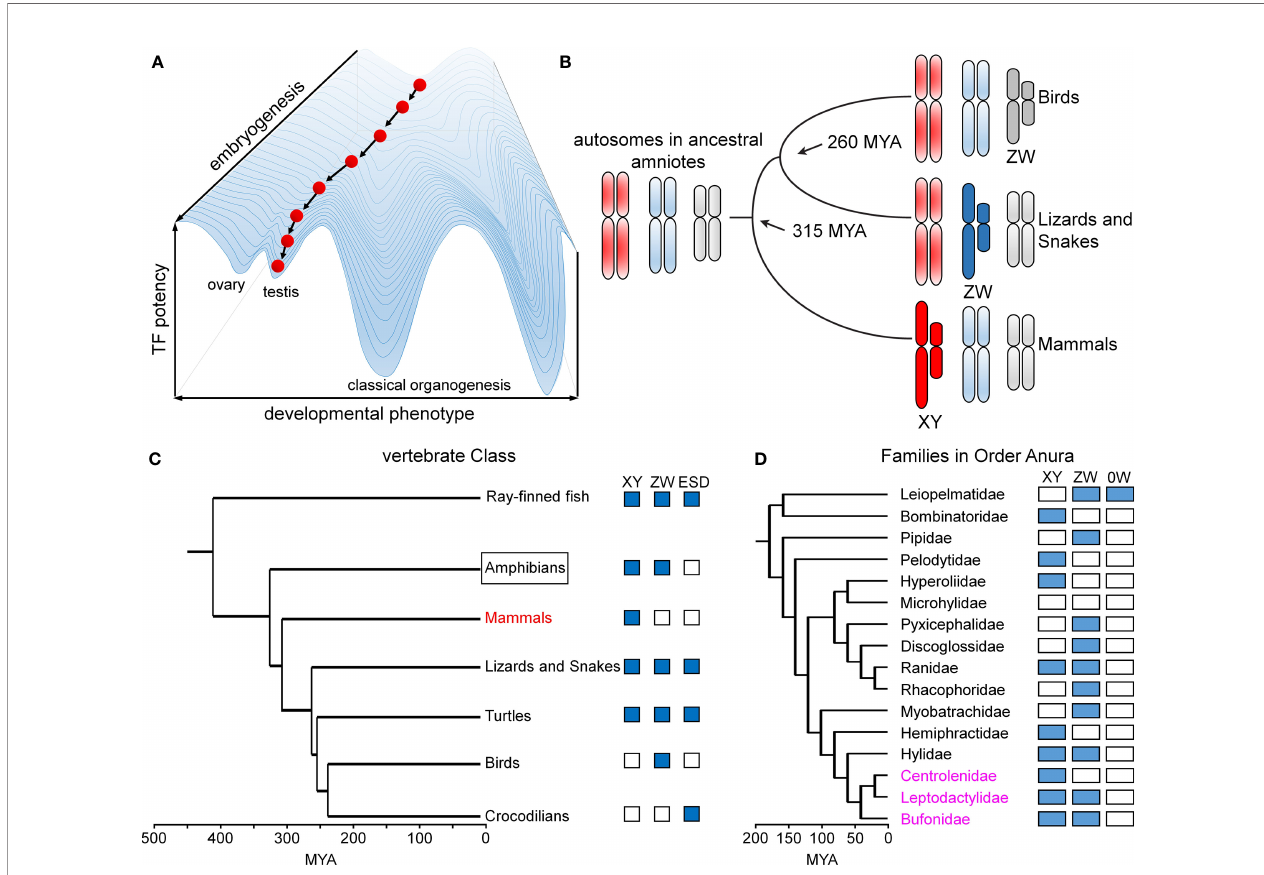
FIGURE 9 | Developmental canalization and fl uidity of vertebrate sex determination. (A) Waddington ’ s principle envisions an epigenetic developmental landscape (49). Canalization ensures robust cell-fate determination in organogenesis. This panel was adapted from (50) as differentiating cells (red ball) follow canalized path to predetermined outcome. (B) Divergence evolution and re-invention of sex chromosomes as exempli fi ed by multiple independent origins of genetic sex-determining mechanisms in birds (ZW), lizards and snakes (ZW) and mammals (XY). This panel was adapted from (51). (C) Phylogeny of vertebrate sex determination (VSD) mechanisms. Boxes indicate distinct sex-determining mechanisms in a given clade; ESD indicates environmental sex determination (52). (D) Time-calibrated phylogenetic tree of frog/toad superfamilies (53). Prominent within this clade (Anura) is fl uidity of sex-determining systems (XY, ZW, 0W). Highlighted in magenta